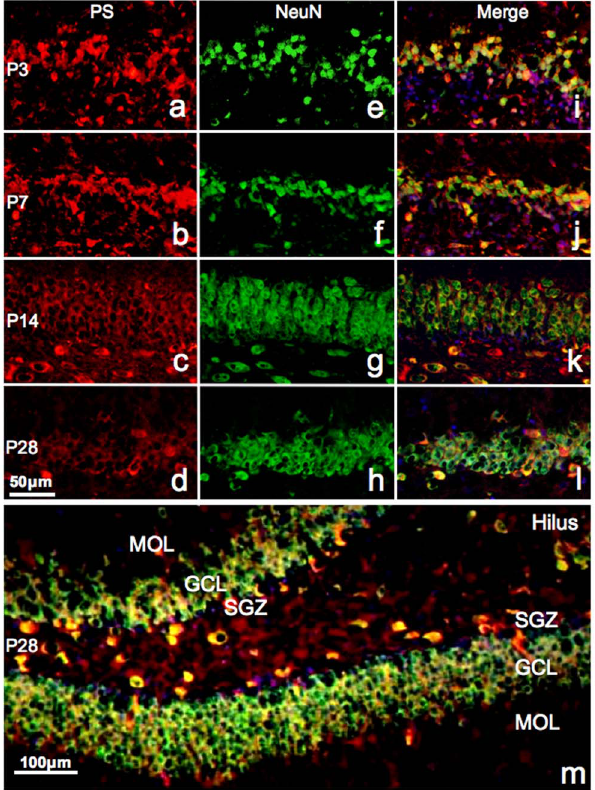
Figure 3. Fluorescent immunoreactivity of PS and NeuN. Fluorescent micrographs of the upper blade of the dentate gyrus showing immunoreactivity of PS (red, a–d ), NeuN (green, e-h ), and their merge ( i–l ) at P3 ( a, e, i ), P7 ( b, f, j ), P14 ( c, g, k ), and P28 ( d, h ,l ). Nuclei are stained with DAPI (blue). A low-power image of the dentate gyrus double-stained with NeuN and PS at P28 is shown in panel m . Note that the majority of prosaposin-positive neurons are also NeuN- positive at all stages.